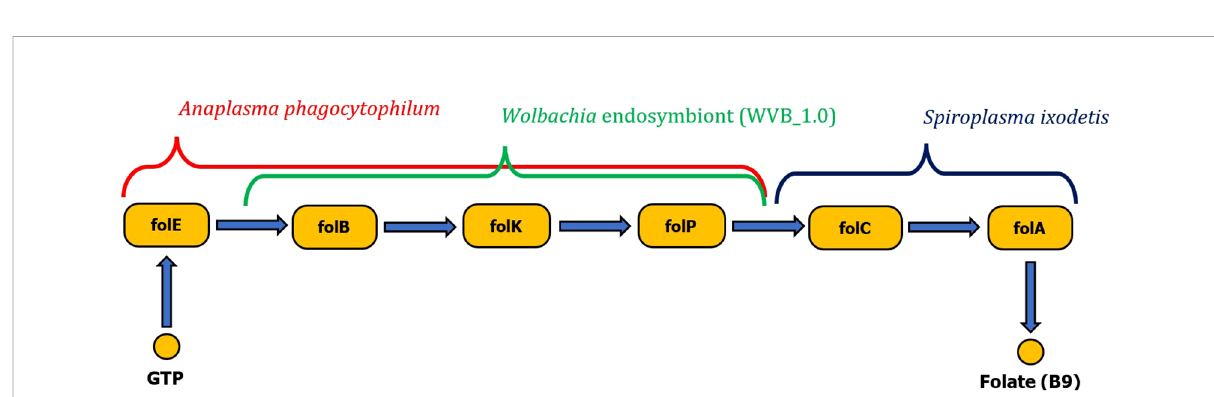
FIGURE 5 Schematic visualization of complete folate biosynthesis pathway formed by two gene clusters originating from either Wolbachia endosymbiont or Anaplasma phagocytophilum pathogen complementary with the Spiroplasma ixodetis gene cluster ( folC , folA